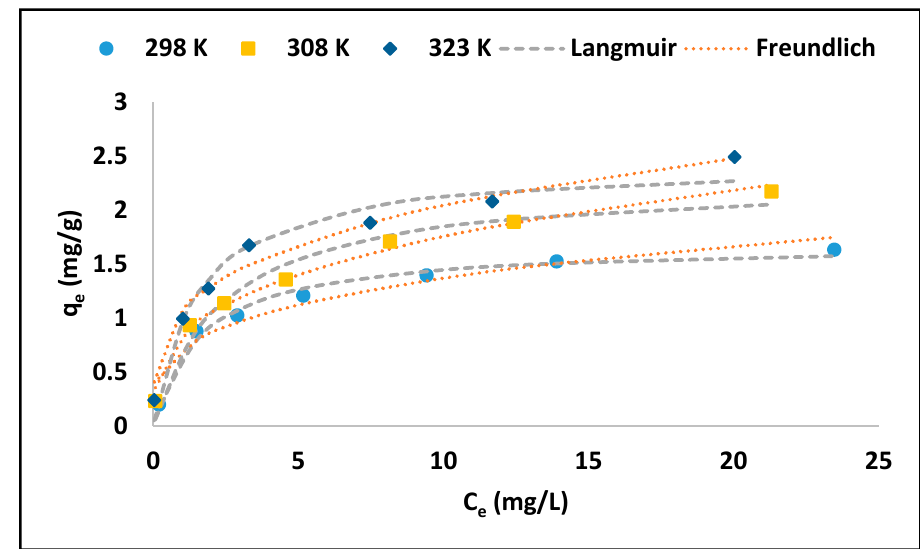
Figure 4. Adsorption isotherms for As(V) removal onto FMK.